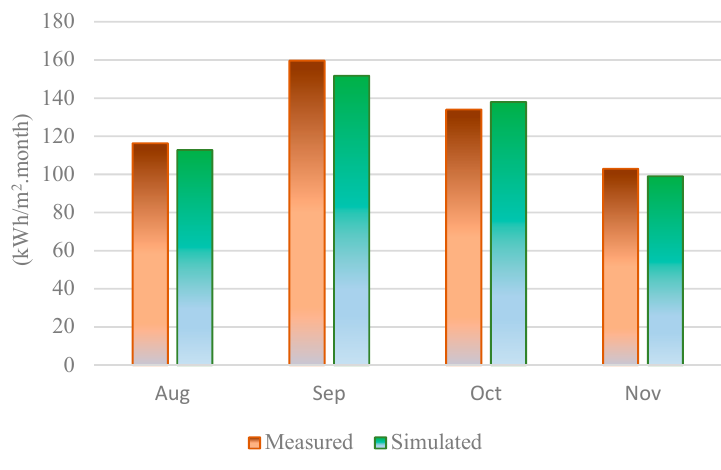
Figure 12. Radiation measured in situ versus simulation data.